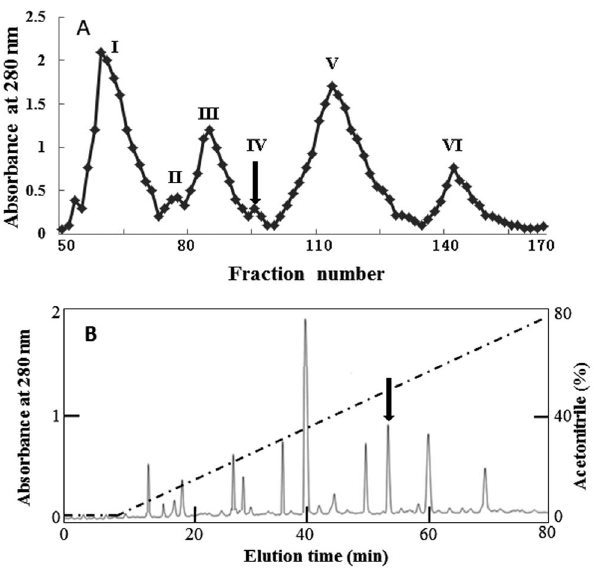
Figure 1. Purification of brachyin from spider venom of B.albopilosum . A: Sephadex G-50 gel filtration of spider venom of B. albopilosum . The spider venom of B. albopilosum was applied to a Sephadex G-50 gel filtration column. The elution was performed by 0.1 M PBS at a flow rate of 0.3 ml/min, collecting fractions of 3.0 ml. The fraction containing insecticidal activity is marked by an arrow. B: The interesting fraction from the Sephadex G-50 gel filtration was further purified by a C8 RP-HPLC column. The elution was performed at a flow rate of 0.7 ml/min with the indicated gradient of acetonitrile in 0.1% (v/ v) trifluoroacetic acid (TFA) in water. Purified brachyin is indicated by an arrow.